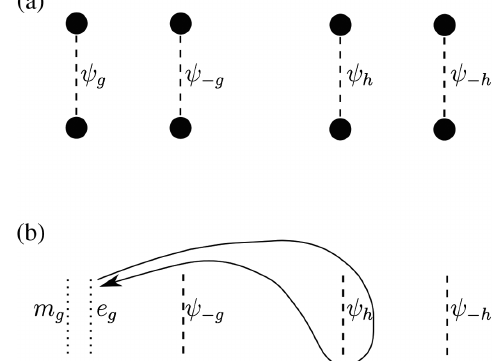
FIG. 7. Performance of a controlled phase gate. Panel (a) shows a logical product state j g; h i stored in the fusion space of eight parafermions. The defect line storing a mode ψ two defect lines storing D ð Z 4 Þ charges e Braiding both endpoints of one of these lines clockwise around the defect line storing the ψ phase ω gh , as